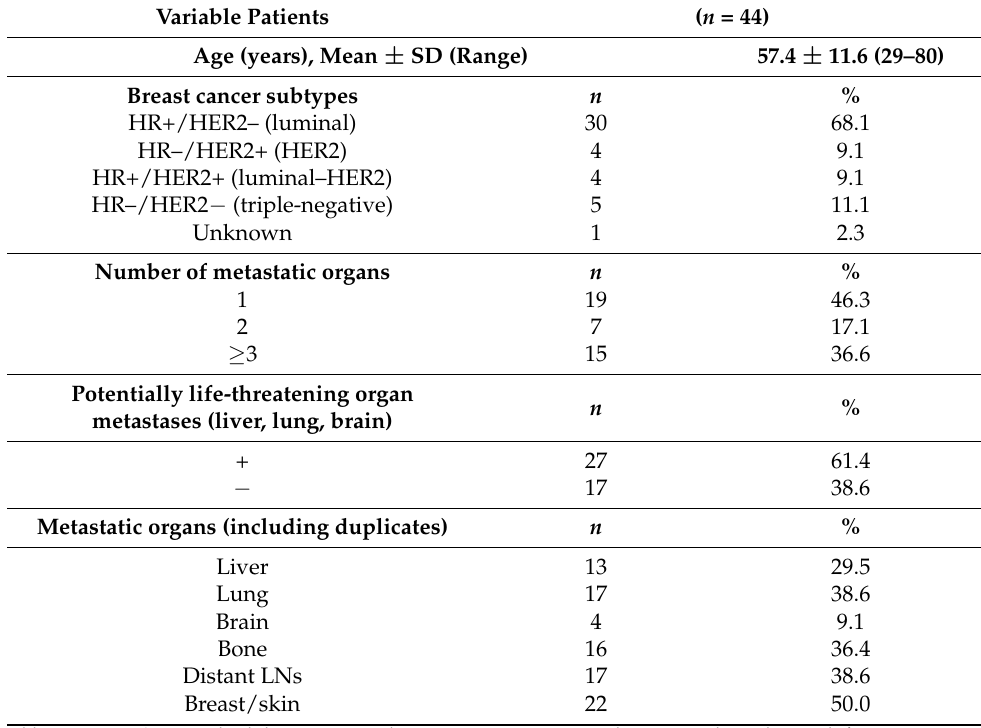
Table 2. Clinical characteristics in patients with metastatic breast